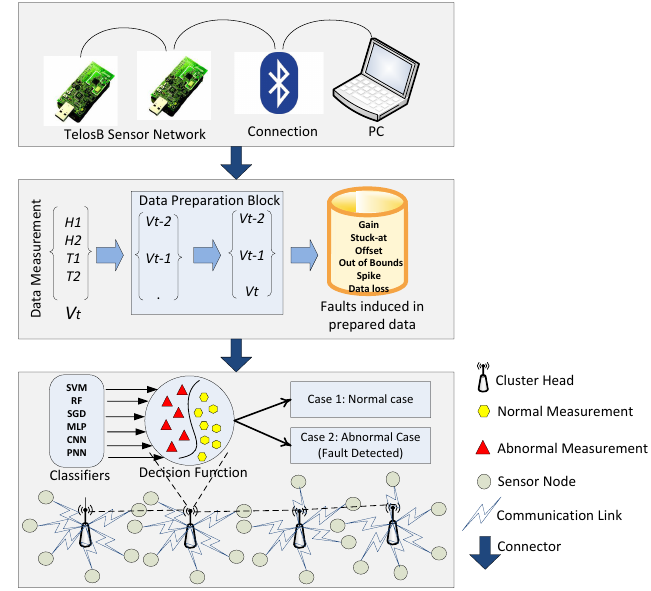
Figure 2. System model of fault